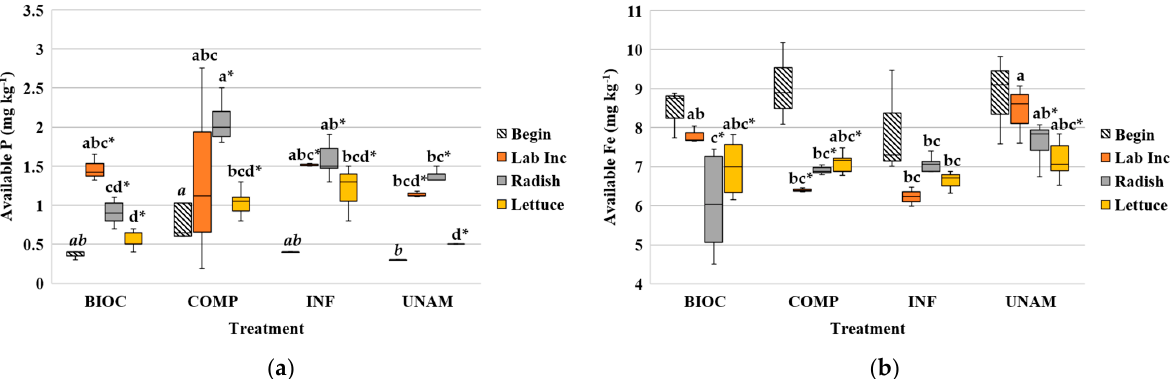
Figure 2. Soil available nutrient concentrations: ( a ) available phosphorus (P) and ( b ) iron (Fe) in soils amended with biochar (BIOC), compost (COMP), inorganic fertilizer (INF), and unamended control (UNAM) at the beginning of the experiment (Begin) presented next to a stepwise comparison of final concentrations for soils planted to radish, lettuce, and lab-incubated soil (Lab Inc). Lower case letters represent statistically significant differences across all treatments and groups. Asterisks indicate a significant difference within each treatment in concentrations between Begin and end (Lab Inc, Radish and Lettuce). Statistical tests were performed using a two-way Analysis of Variance (ANOVA) or Kruskal-Wallis if data could not be normalized. Tukey HSD and Dunn’s test (non-normal data) were used to determine treatment significance at a p ≤ 0.05.